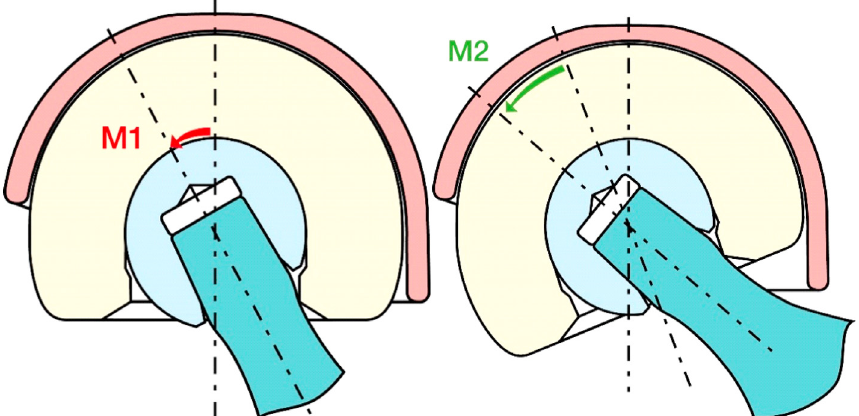
Figure 1. Showing the DMC concept. It consists of two distinct articulations, one between the polyethylene insert and the femoral head (M1) and one between the insert and shell (M2). This allows greater range of motion before impingement of the femoral neck occurs. The figure is the property of Biomet, which have granted their permission for usage in this